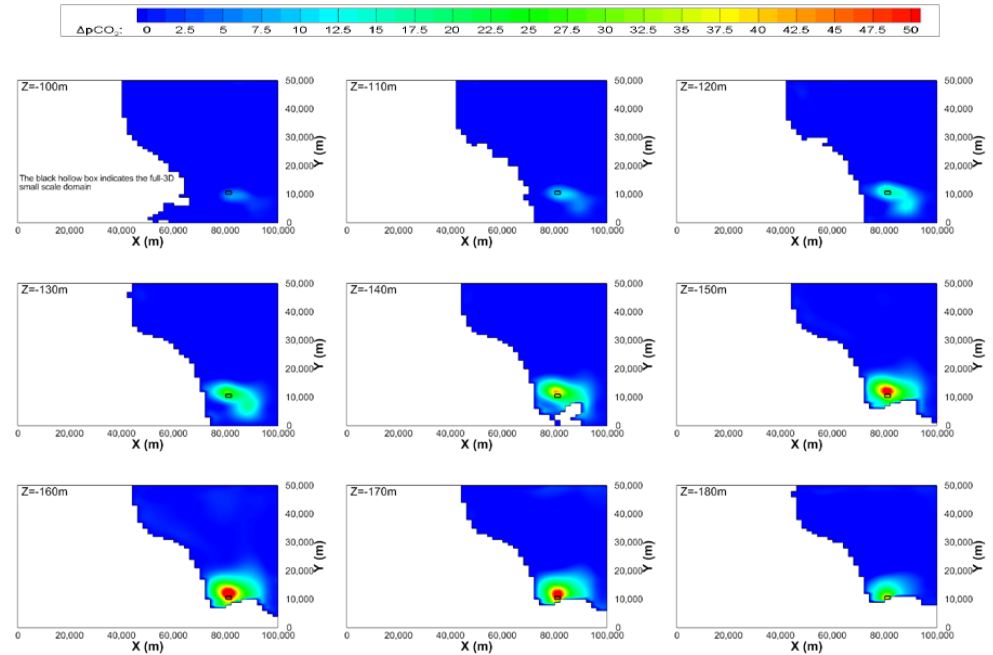
9 Figure 9. Contour maps of ∆ pCO 2 in the constant z planes of the mesoscale domain at 30 days after the start of leakage for case 3 (leakage rate = 100,000 t /